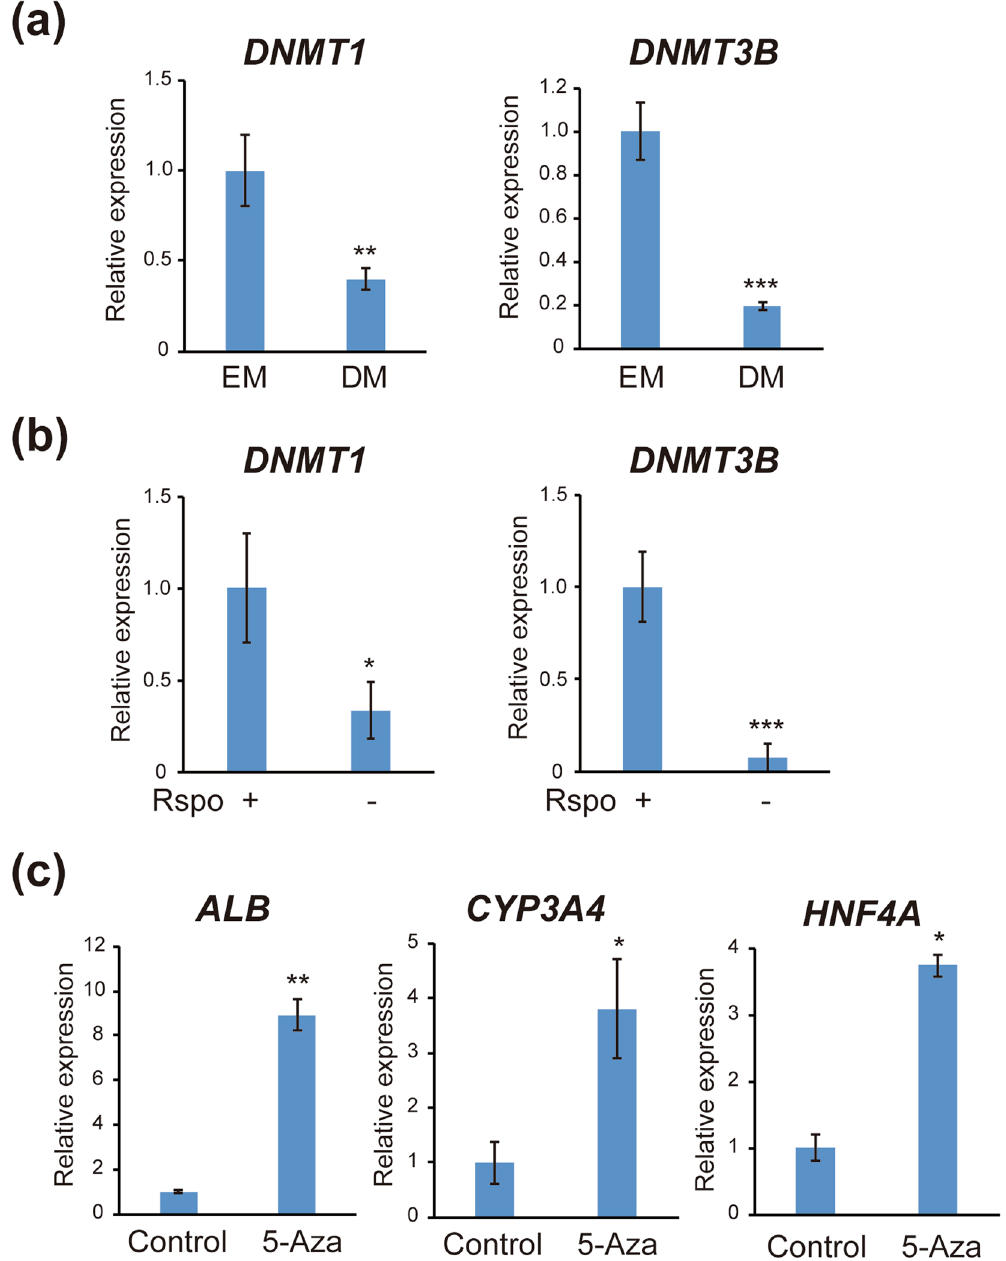
Figure 3. Expression of DNMT1 and DNMT3B during hepatocyte differentiation. ( a ) Relative expression of DNA methyltransferases DNMT1 and DNMT3B in IHCC organoids cultured in EM or DM. ( b ) Relative expression of DNMT1 and DNMT3B in IHCC organoids cultured in EM, or in EM without R-spondin 1 (Rspo). ( c ) Relative expression of Albumin ( ALB ), CYP3A4 and HNF4A in IHCC organoids after treatment with 1 μ M 5-Aza-CdR